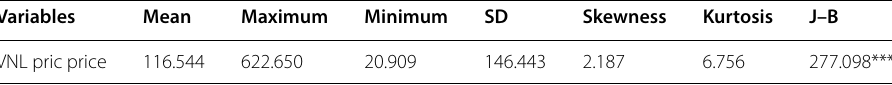
***is the significance level at 1%